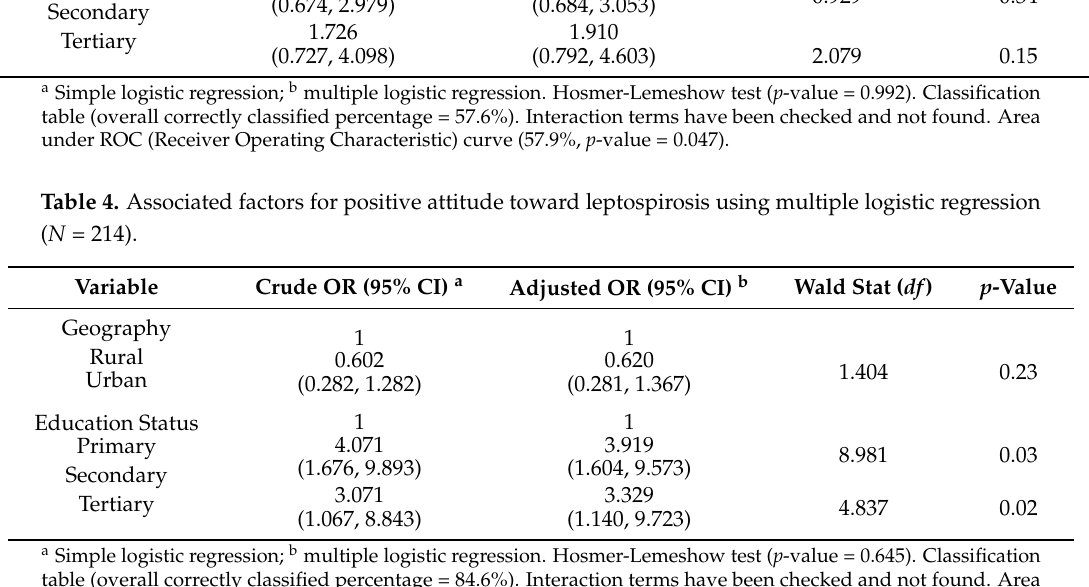
under ROC curve (66.1%, p -value